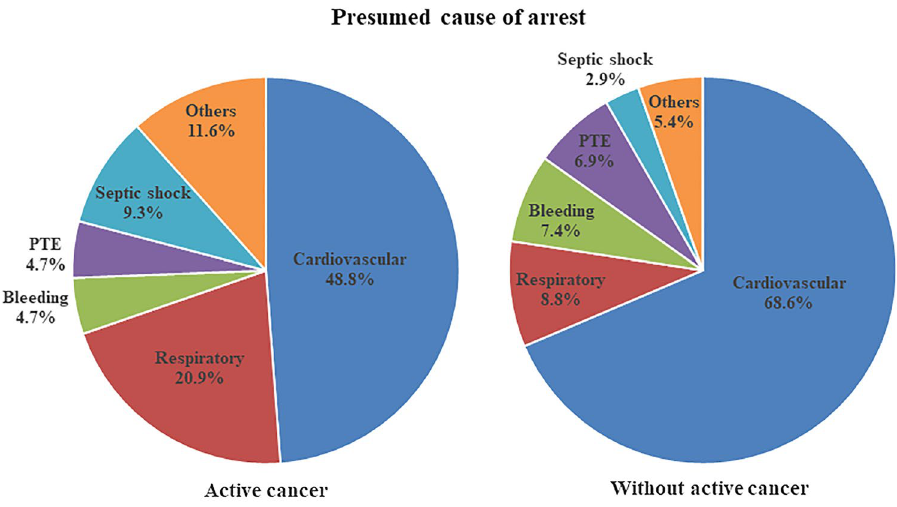
Figure 1. Presumed causes of cardiac arrest in patients with and without active cancer PTE Pulmonary